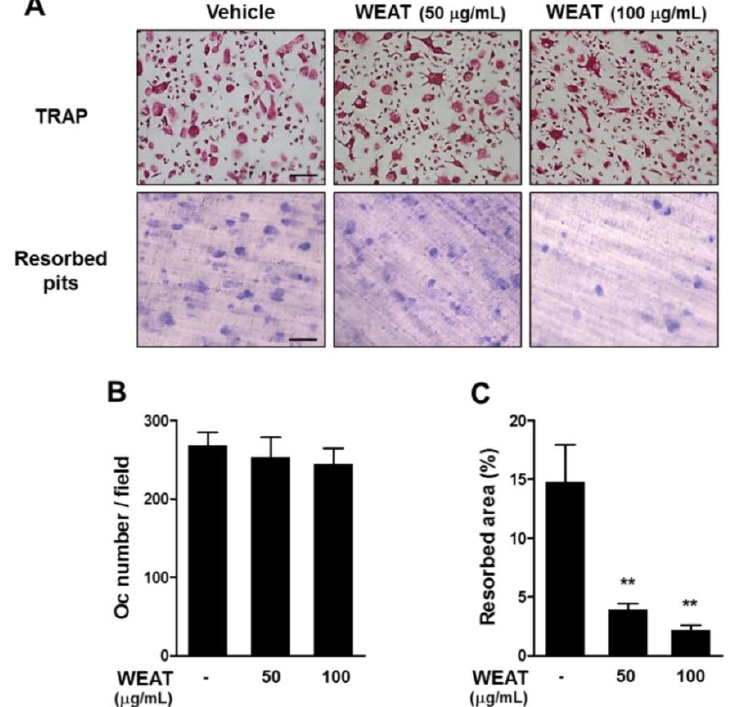
(100 ng/mL) for 16 h. ( A ) TRAP staining (upper panel) and resorbed pits by osteoclasts (down panel). Scale bars represent 100 μm. ( B ) The number of osteoclasts (Oc). ( C ) The total area of resorbed pits. ** p < 0.01 versus vehicle-treated